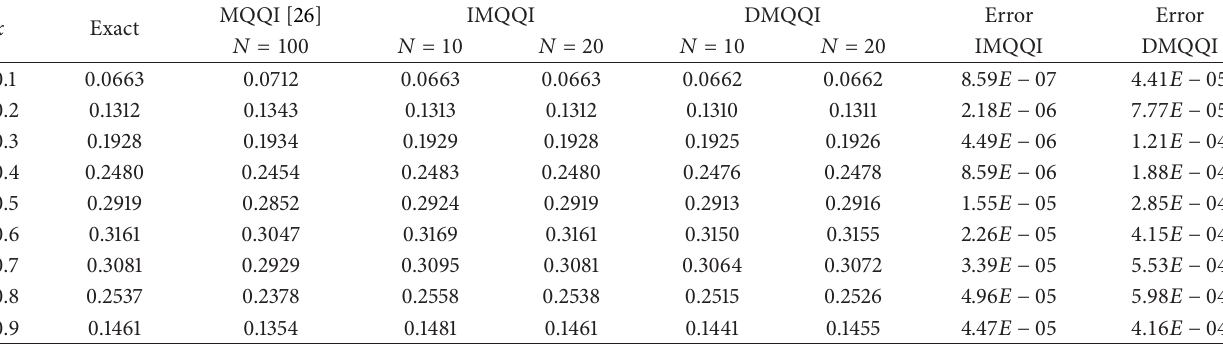
Table 1: Comparison of results with the exact solution and the results in [26] of 𝜐 = 0.1 with Δ𝑡 = 0.001 at 𝑡 = 1 for different values of 𝑥 of Experiment 1.